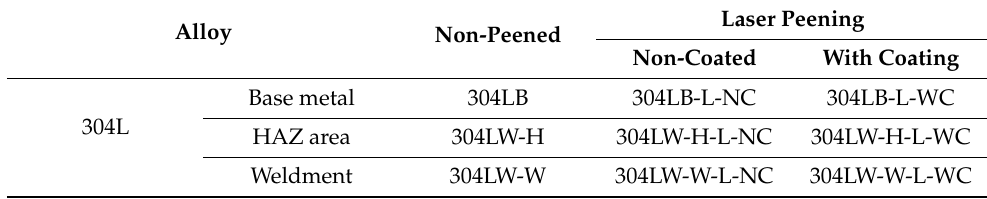
Table 3. Designation of the experimental specimen [18].